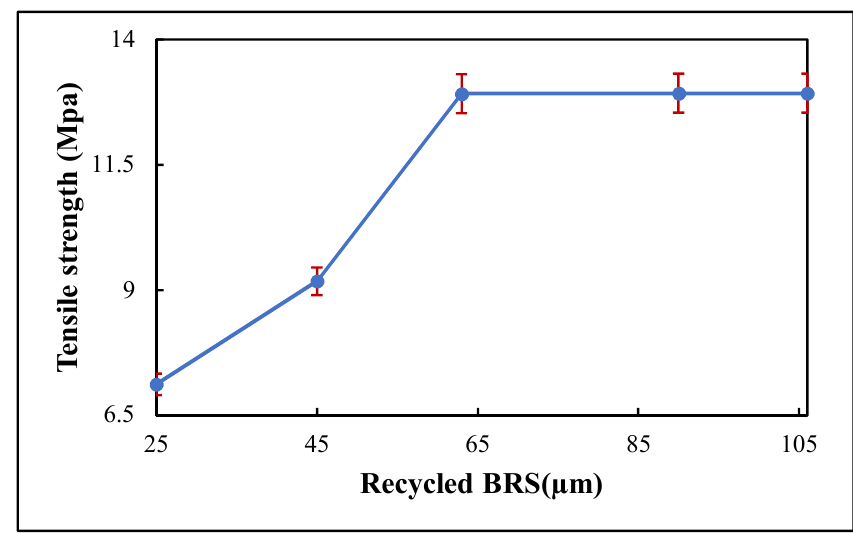
Figure 7. Variation of tensile strength with filler size.